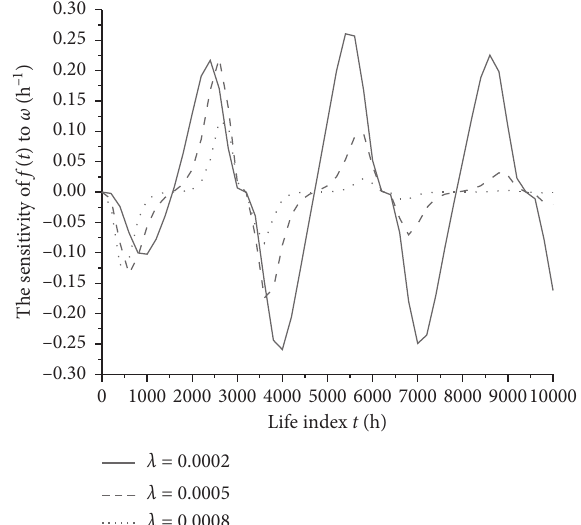
Figure 24: The sensitivity of h ( t ) to 2 ω ( λ �